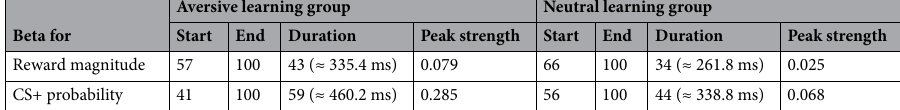
Aversive learning group Neutral learning group Beta for